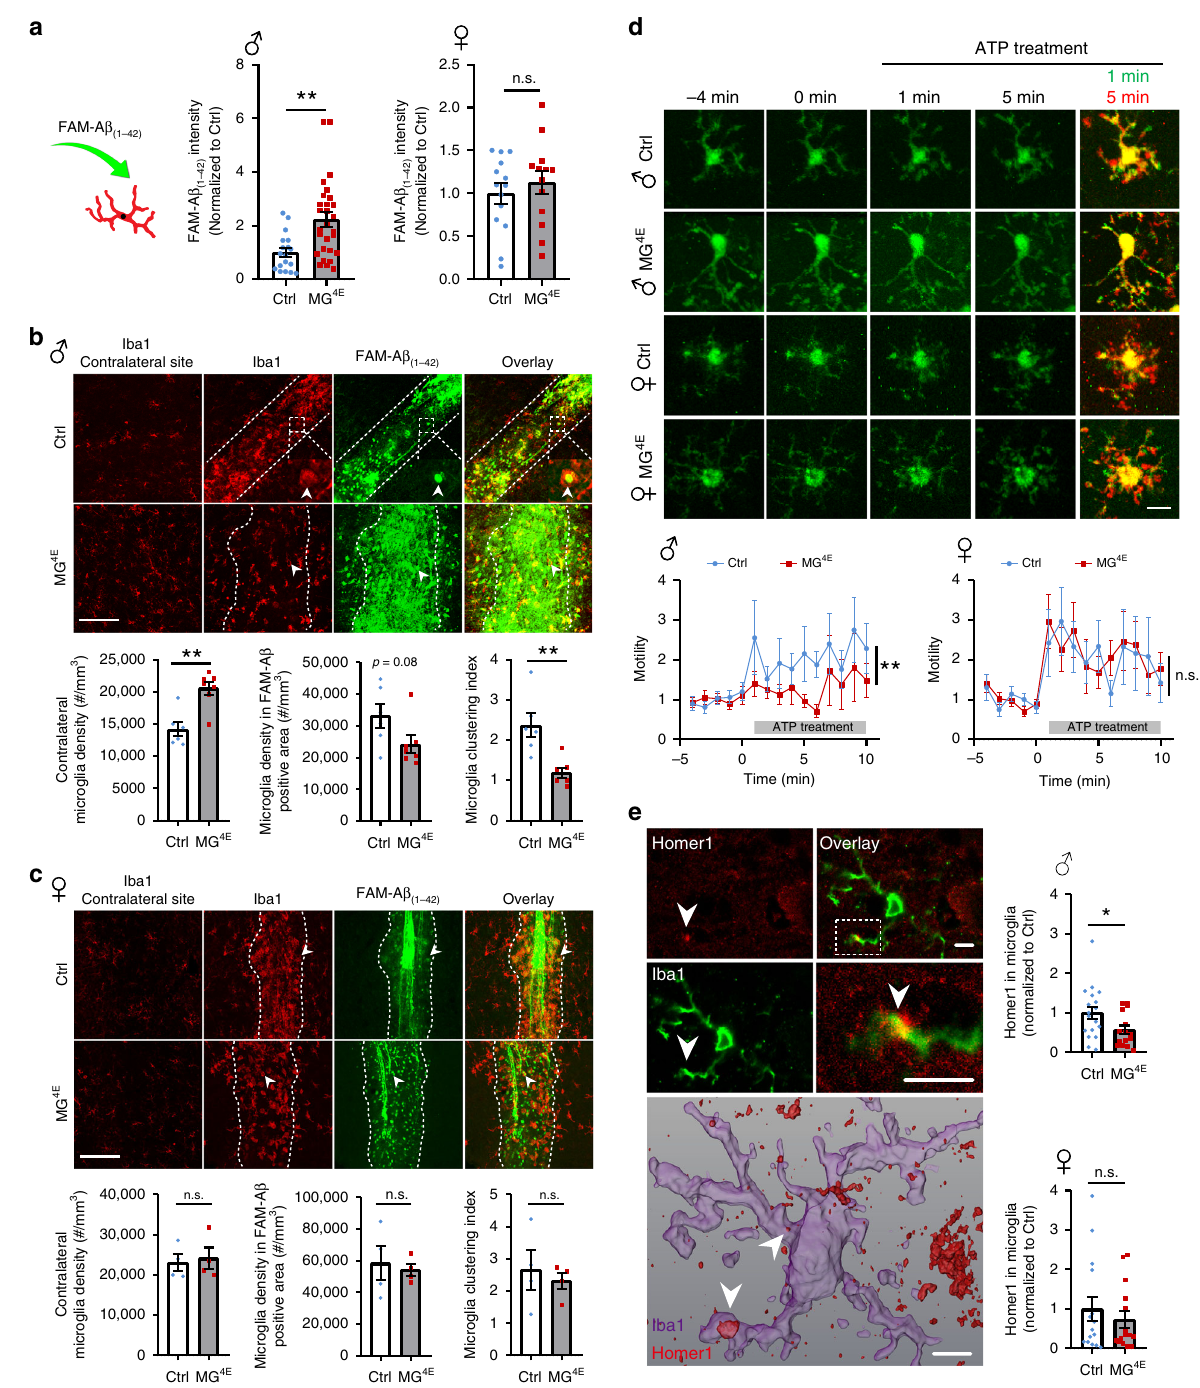
Fig. 8 Microglial surveillance and synapse engulfment in MG 4E mice. a Phagocytosis of FAM-A β (1 – 42) in cultured control and MG 4E microglia. Male, n = 18 for control and n = 28 for MG 4E ; female, n = 14 for control and n = 13 for MG 4E . ** p = 0.0017 and n.s. not signi fi cant ( p = 0.4919) by two-sided t -test. b , c Migration of microglia into FAM-A β (1 – 42) injection sites in 2-week-old male ( b ) and female ( c ) control and MG 4E mice. Microglia clustering index is de fi ned as (density of Iba1 + cells in the FAM-A β -covered area)/(density of Iba1 + cells in a contralateral site). Male, n = 6 control mice and 7 MG 4E mice; female, n = 4 per genotype. Two-sided t -test: male mice, contralateral microglia density, ** p = 0.0013; clustering index, ** p = 0.0026, n.s. not signi fi cant. Scale bars, 100 μ m. d Microglial surveillance in response to ATP treatment in male and female MG 4E microglia at P14 – P18. Microglial baseline motility was recorded for 5min, then ATP was bath-applied to brain slices and recorded for another 10min. Data was normalized to the mean process motility of fi rst 5 min. Male, n = 15 microglia from 3 control mice and 20 microglia from 3 MG 4E mice; female, n = 18 microglia from 3 control mice and 26 microglia from 3 MG 4E mice. Male, two-way ANOVA for genotype during ATP treatment, F (1, 330) = 9.566, p = 0.002; female, two-way ANOVA for genotype during ATP treatment, F (1, = 0.045, p = 0.831. Scale bar, 10 μ m. e Engulfment of Homer1 by microglia. Upper panel shows confocal images of Homer1 and Iba1 double 420) immunohistochemistry, and lower panel shows 3-D reconstruction of a microglial cell and Homer1 immunoreactivity. Arrowheads denote Homer1 inside the microglia. Male, 18 microglia from 6 control mice and 15 microglia from 5 MG 4E mice; female, 15 microglia from 5 mice per genotype. * p = 0.0378 and n.s., not signi fi cant ( p = 0.4891) by two-sided t -test. Scale bars, 5 μ m. All data are shown as mean ± s.e.m. Source data are provided as a Source Data fi